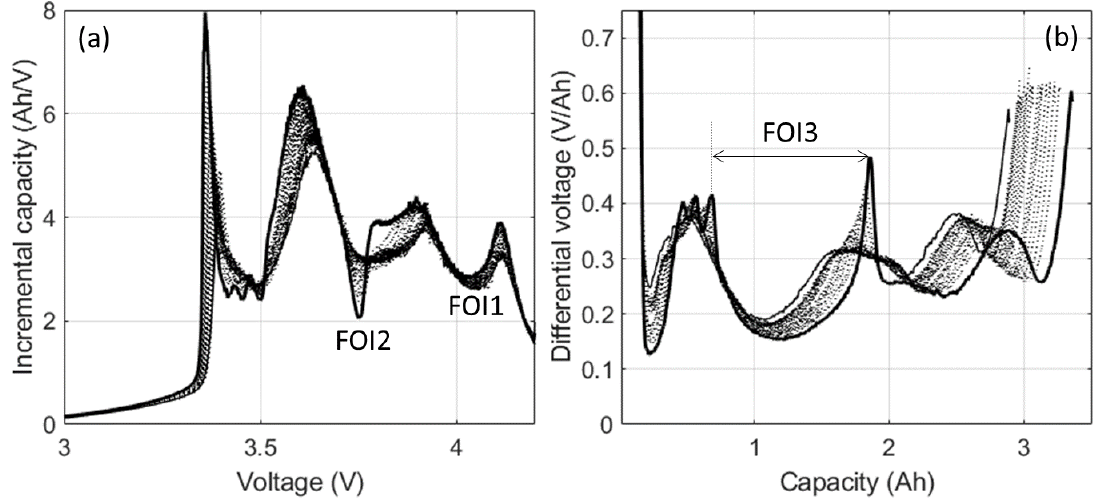
Figure 3. Representative ( a ) incremental capacity and ( b ) differential voltage curve evolutions at C/35 under the aging conditions tested. FOI: features of interest.